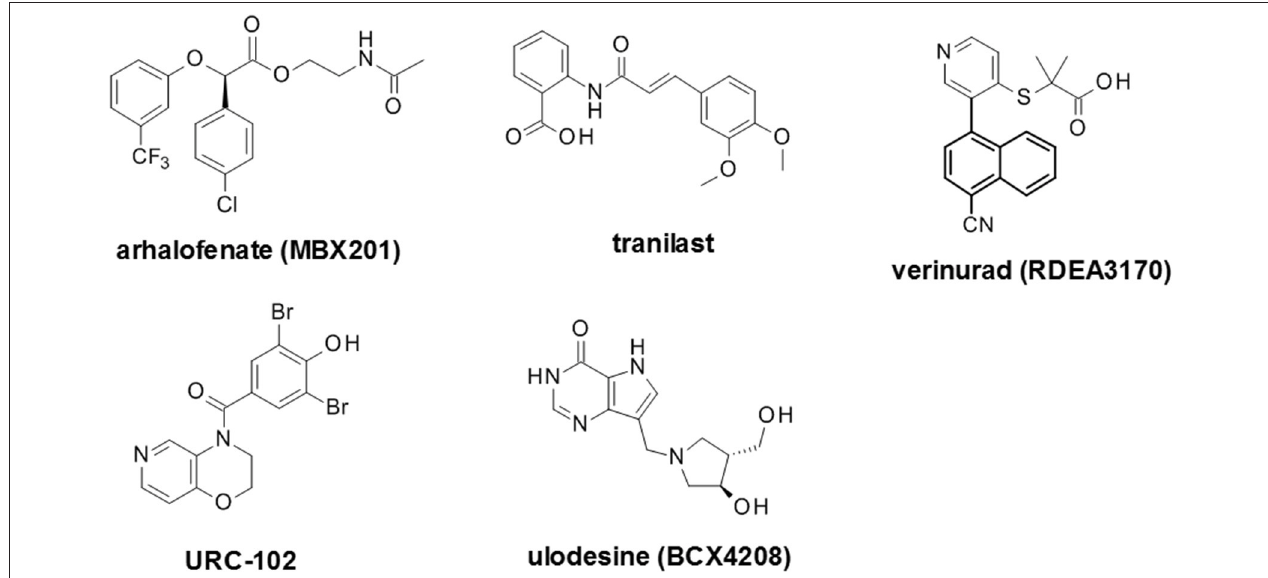
FIGURE 6 | Selected recent emerging clinical compounds (where structure disclosed). The structures for arhalofenate (MBX201), tranilast, verinurad (RDEA3170), URC-102 and ulodesine (BCX4208) are shown here.